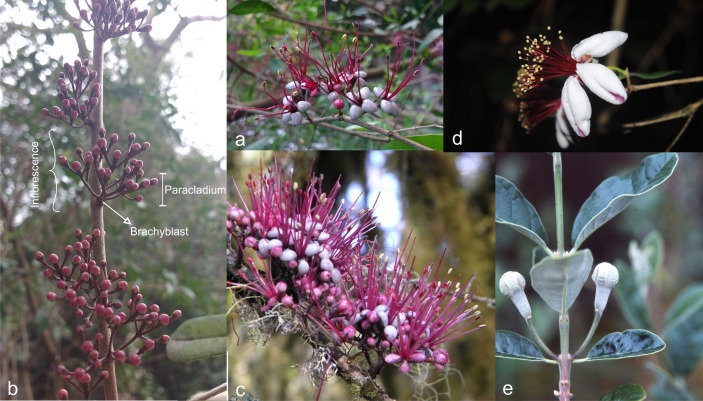
Flowers and Inflorescences.Myrrhinium atrupurpureum (A, B, C): (A) Flowers. (B) Cauliflorous inflorescences with closed flower buds; note the degree of branching of paracladia supported by each brachyblast. (C) Inflorescences with floral buds and open flowers; note the different degree of development and colour of petals and the typical appearance of brush-like inflorescence. Acca sellowiana (D, E): (D) Flowers. (E) Inflorescence with uniflorous paracladia in the axil of leaves. Photo credits: A and B, María Gabriela Nadra; C, Alfredo Grau, Universidad Nacional de Tucumán, Argentina; D, Andrés Gonzalez via http://floranativadeuruguay.blogspot.com.ar; E, Pat Breen, Oregon State University.